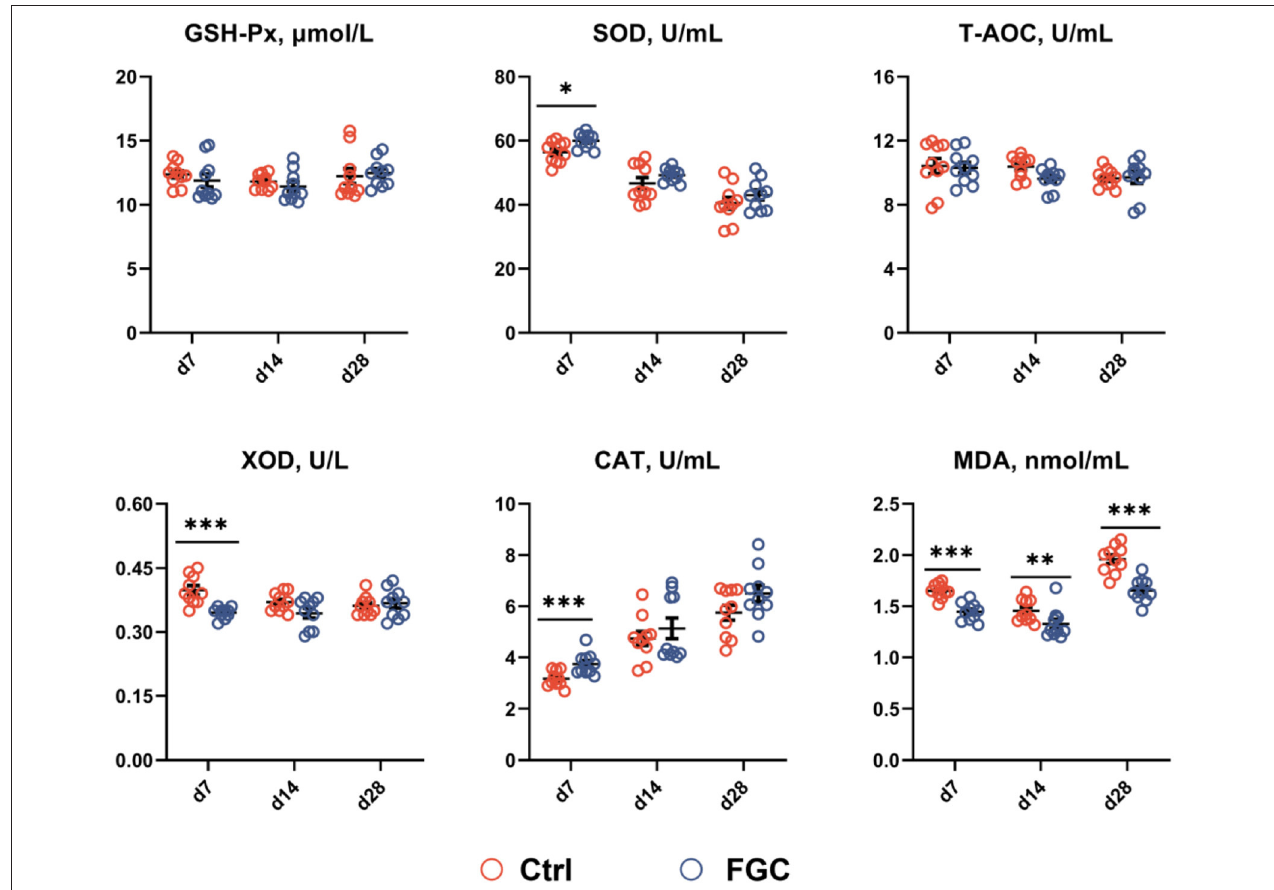
FIGURE 2 | Serum antioxidant capacity of 7d, 14d and 28d-piglets as affected by dietary ferrous glycine chelate supplementation. GSH-Px, glutathione peroxidase; SOD, superoxide dismutase, T-AOC, total antioxidant capacity; XOD, xanthine oxidase; CAT, catalase; MDA, Malondialdehyde. Ctrl, corn-soybean basal diet; FGC, corn-soybean basal diet with 2,000 mg/kg ferrous glycine chelate. Data were shown as means ± SEM. * p < 0.05; ** p < 0.01; *** p < 0.001. N =